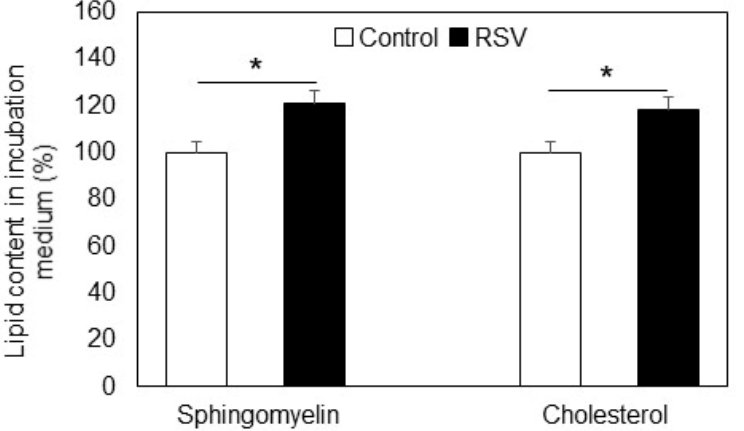
Figure 3. Content of sphingomyelin and cholesterol in the incubation medium of A549 cells untreated (Control, white bars) and treated with resveratrol (RSV, black bars). Values are expressed as % of controls (100%). Values are means ± SD. The differences between the values obtained for both SM and CH were statistically significant. * p < 0.01.